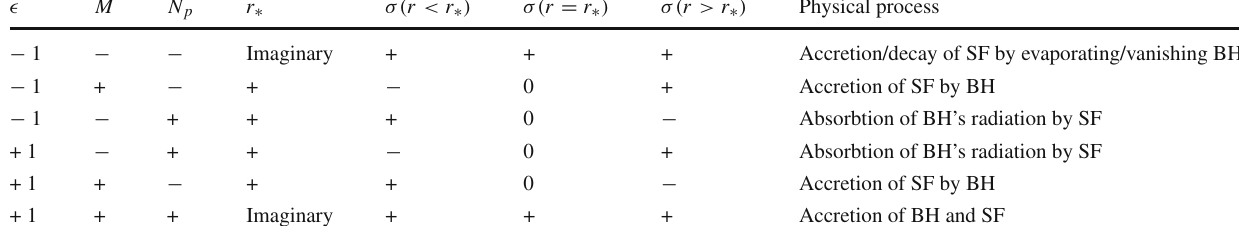
Table 7 BH and its surrounding phantom field parameters for (cid:5) = ± 1. For the phantom background, the positive energy condition may be completely or partially respected regarding to the above situations